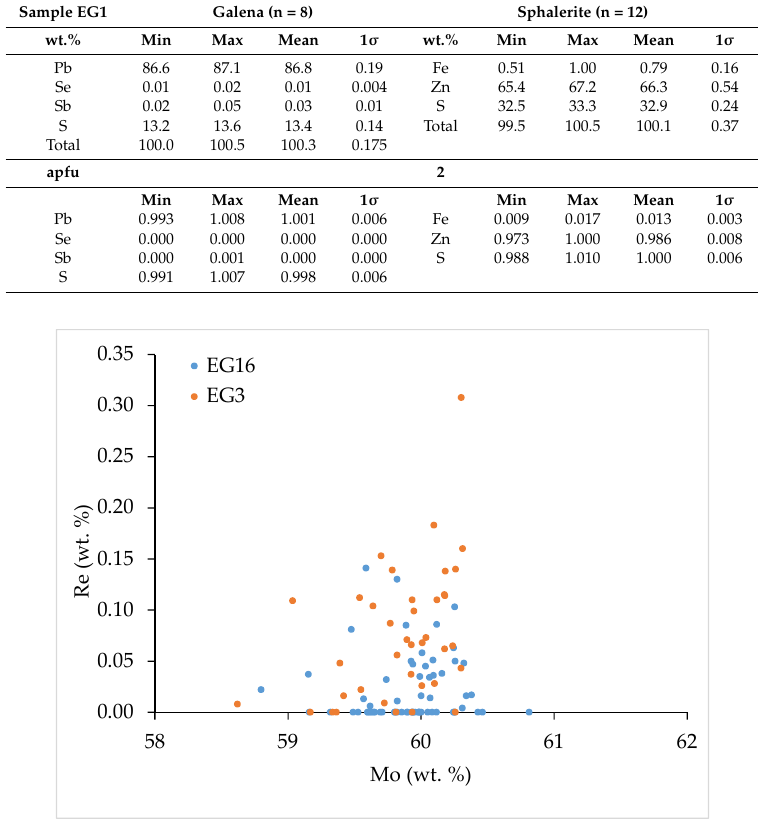
Figure 7. Mo vs Re plot of analysed molybdenites from the porphyry-style mineralization of the Aisymi-Leptokarya prospect.